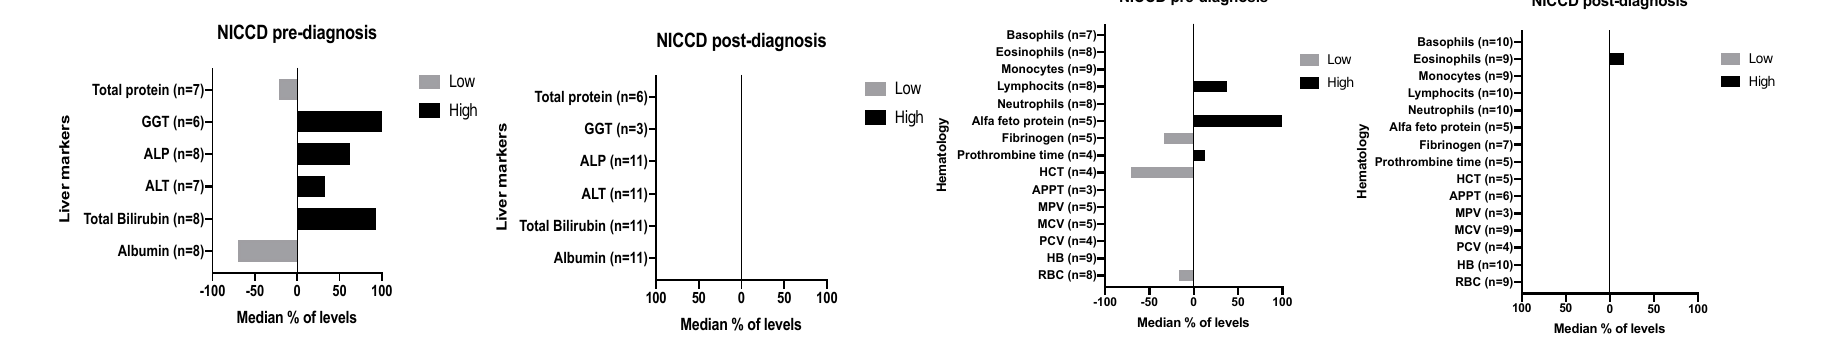
Figure 3 . Median % of levels > and < reference range for liver biochemical markers and haematology parameters pre- and post-diagnosis in NICCD patients. Abbreviations: